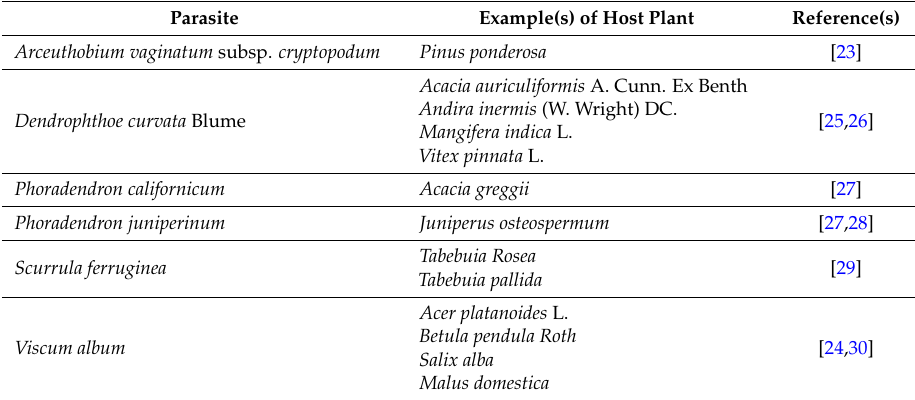
Table 1. Parasitic mistletoe plants found in different host